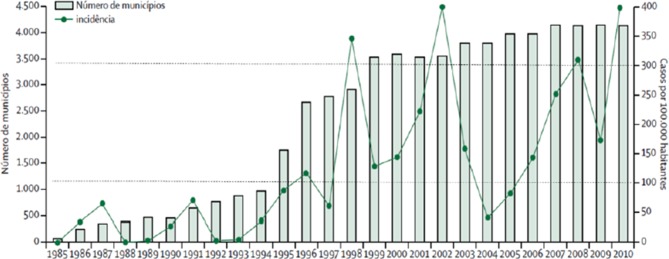
Dengue incidence and number of municipalities reporting dengue cases in Brazil, 1985-2010 (Source: Barreto et al., 2011).